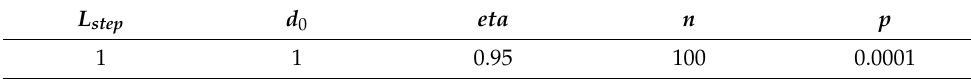
Table 7. Related parameter values in the operation of BAS.